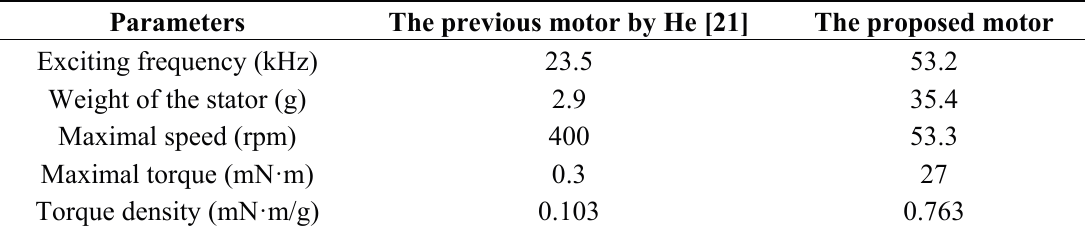
Table 2. Comparison between the proposed motor and a previous work.